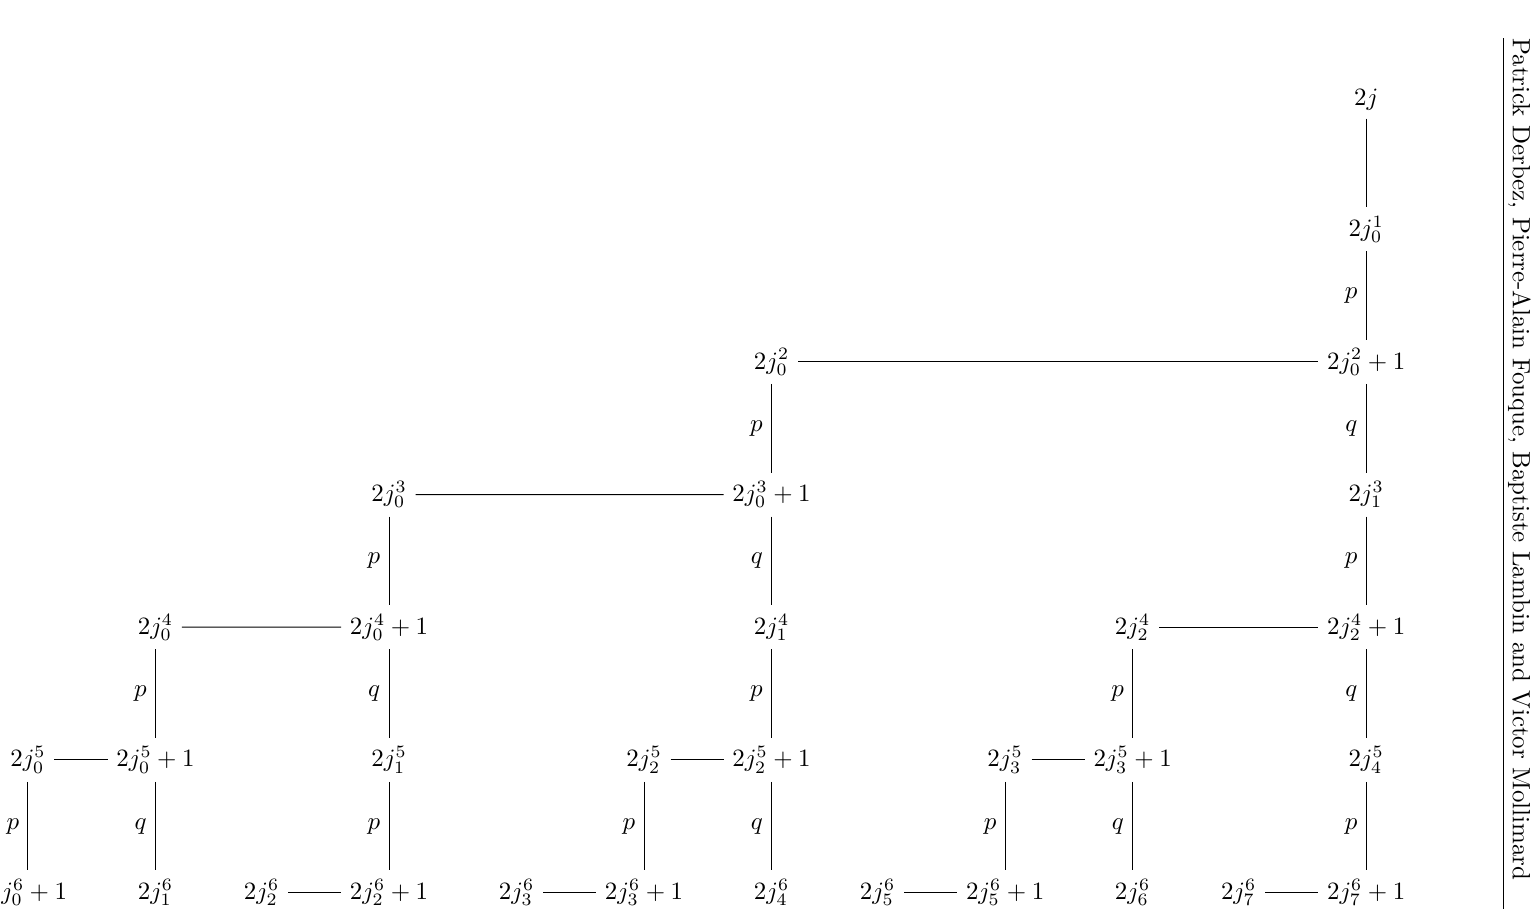
Figure 2: Propagation tree for 7 rounds (minus the last application of π